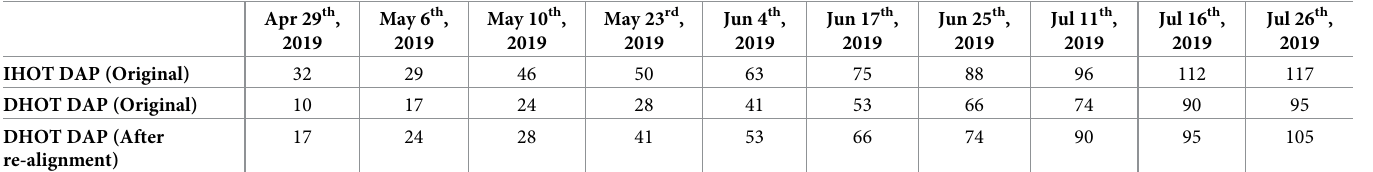
Table 1. Crop growth and reproductive stages of IHOT and DHOT trials in terms of their Days After Planting (DAP), before and after re-alignment of DHOT crops’ growth